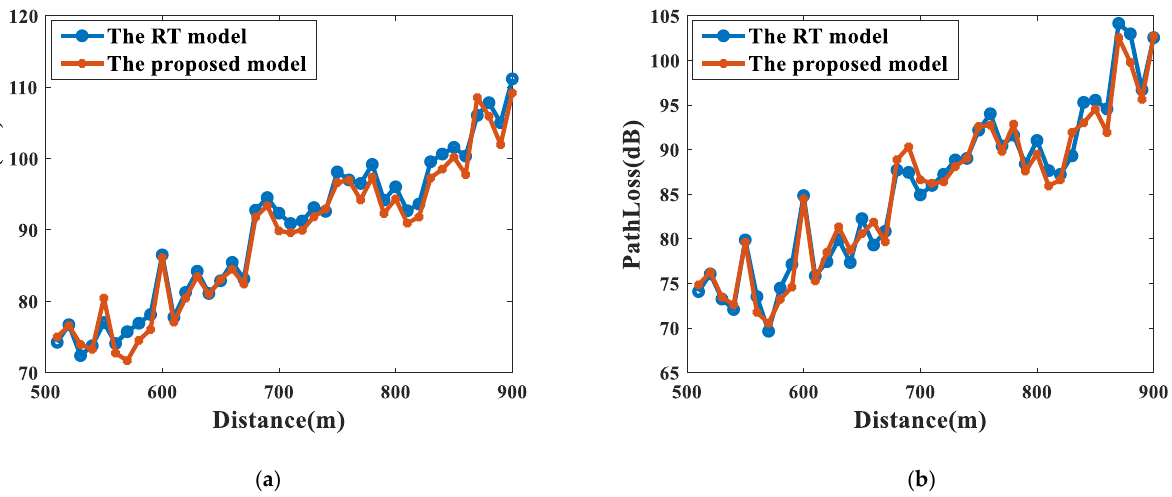
Figure 14. The comparison between the RT model in [32] and the proposed model at 5.6 GHz. ( a ) R = 500 m; ( b ) R = 1000 m.